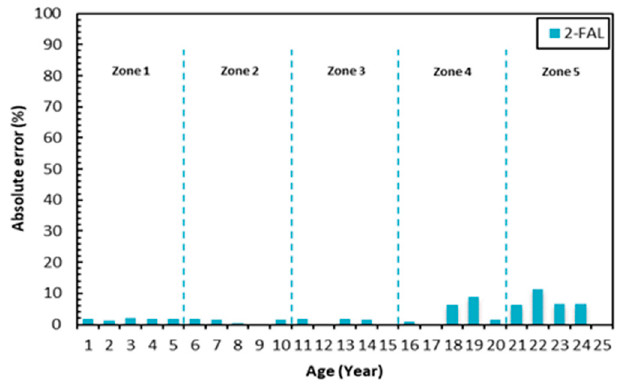
Figure 9. Percentage of absolute error between computed and predicted 2-furfuraldehyde.